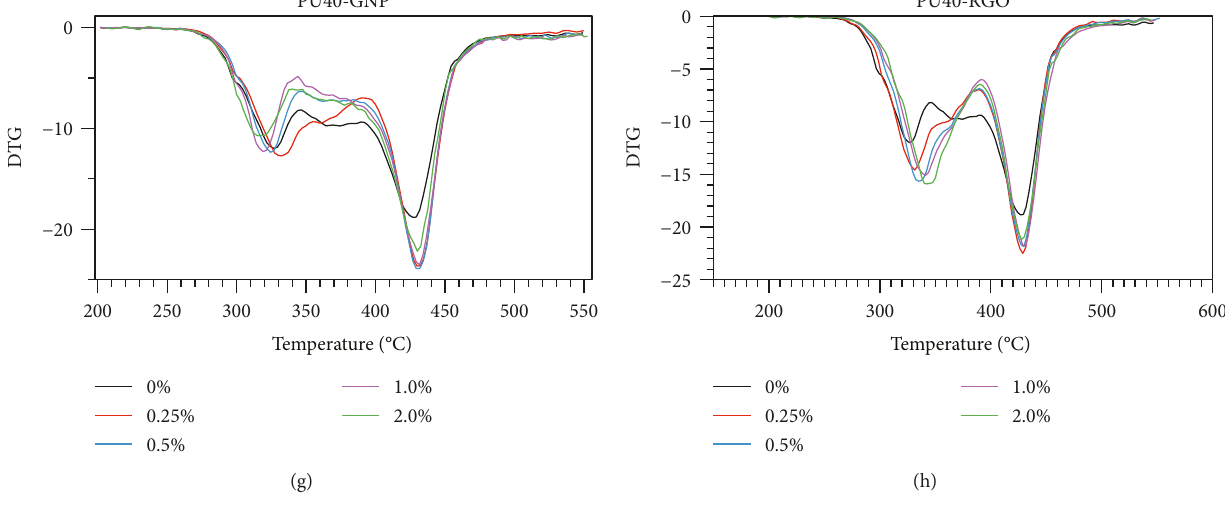
Figure 13: TG curves [%mass versus temperature and derivative (DTG) versus temperature] for PU nanocomposites. Table 3: TG data for PU nanocomposites. % nano fi